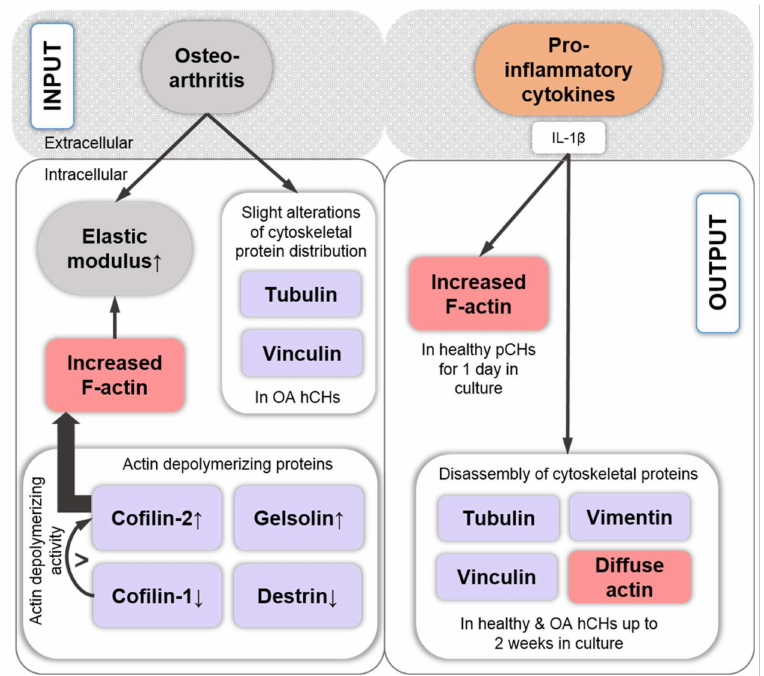
Figure 5. Cytoskeletal differences between healthy and osteoarthritis (OA) hCHs were detected for tubulin, vinculin, gelsolin, destrin, cofilin-1, and cofilin-2 [205]. Due to the increase in the latter and its higher actin assembly activity [206], presumably causing overall enhanced F-actin, results in elevated cell elastic moduli. The pro-inflammatory cytokine IL-1 β increased F-actin in healthy pCHs that were cultured for 1 day [70], but also induced disassembly of tubulin, vimentin, vinculin, and actin in healthy and OA hCHs that were cultured for up to 2 weeks [199]. Abbreviations: IL-1 β : interleukin-1 β , OA: osteoarthritic, hCHs: human chondrocytes, pCHs: porcine chondrocytes. The up and down arrows indicate an increase or